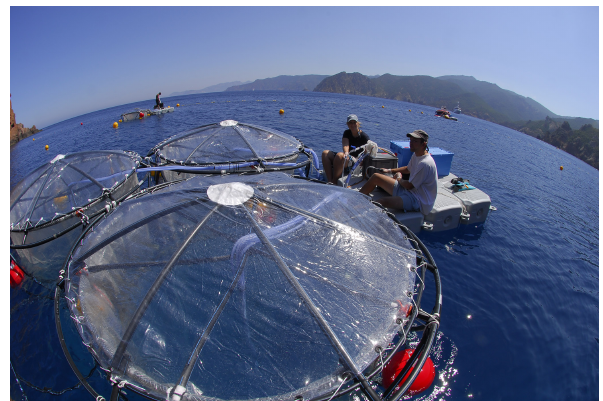
Fig. 7. Sampling the mesocosms. Each cluster of three mesocosms is simultaneously sampled a plastic platform by a team of two scien- tists. Overall a sampling sequence duration was less than two hours (photo: D. Luquet OOV).